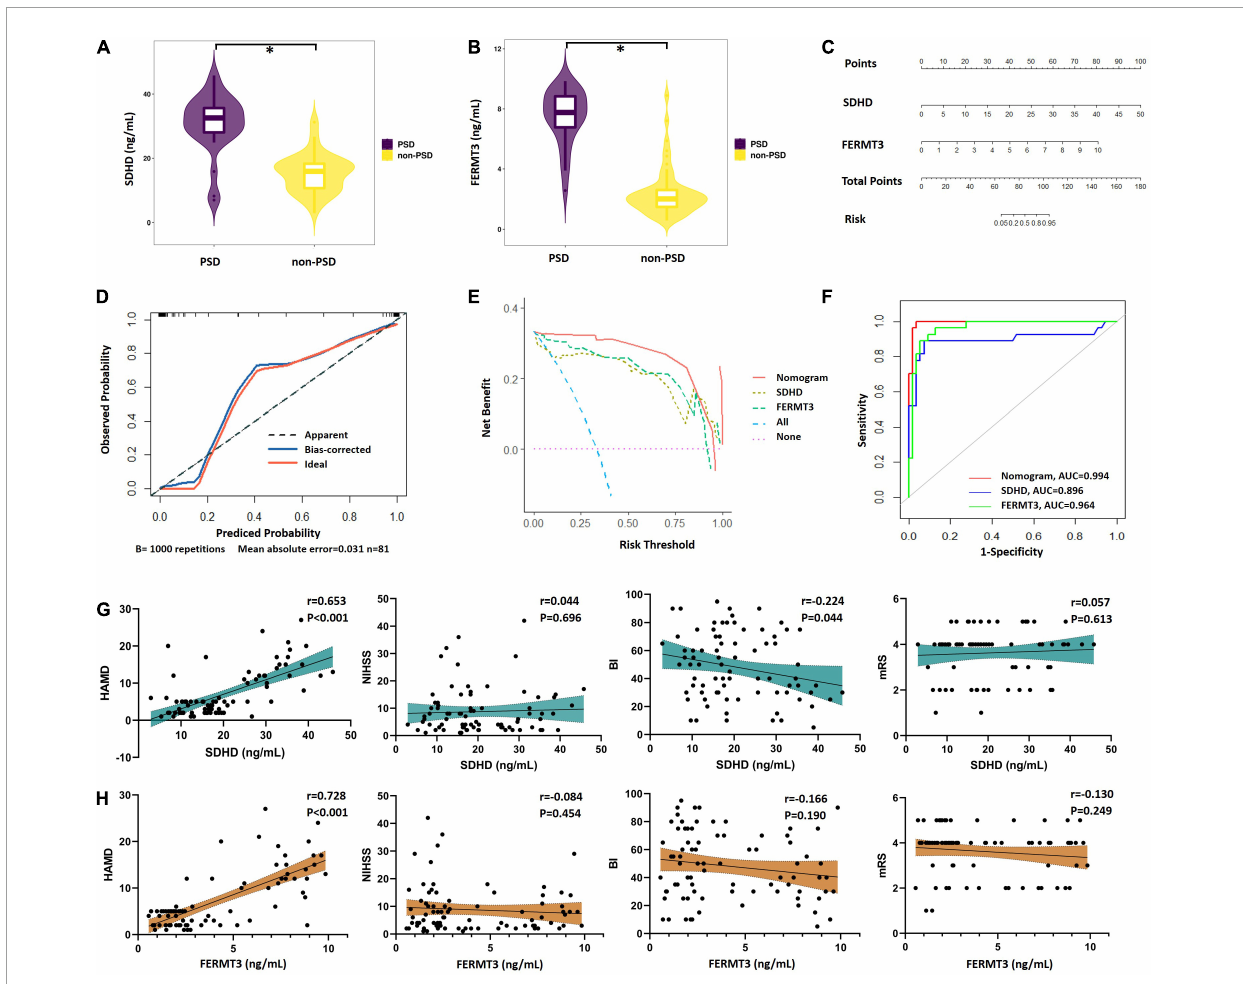
FIGURE7 Performance of signature genes in PSD patients. (A) Expression level of SDHD in PSD and non-PSD groups. (B) Expression level of FERMT3 in PSD and non-PSD groups. (C) Nomograms for the prediction of the PSD risk. (D) Scatter diagram of calibration plot for internal verification of the nomogram model. (F) DCA curves of the nomogram model. (E) ROC curves of the nomogram model. (G) Correlation between expression of SDHD and four clinical traits (HAMD, NIHSS, BI, and mRS). (H) Correlation between expression of FERMT3 and four clinical traits (HAMD, NIHSS, BI, and mRS). PSD, post-stroke depression; DCA, decision curve analysis; ROC, receiver operating characteristic; AUC, area under the curve; HAMD, Hamilton Depression Rating Scale 17-item; NIHSS, National Institute of Health Stroke Scale; BI, Barthel index; mRS, Modified Rankin Scale. ∗ P <